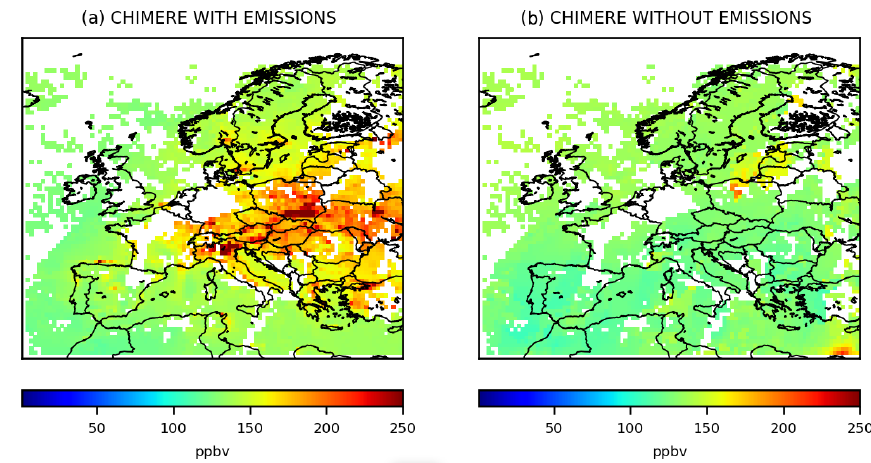
Figure 3. Mean CO surface concentrations from 1 to 7 March 2015 simulated by CHIMERE (a) with anthropogenic and biogenic emissions, and (b) without emissions, in ppbv, at the 0.5 ◦ × 0.5 ◦ grid-cell resolution.